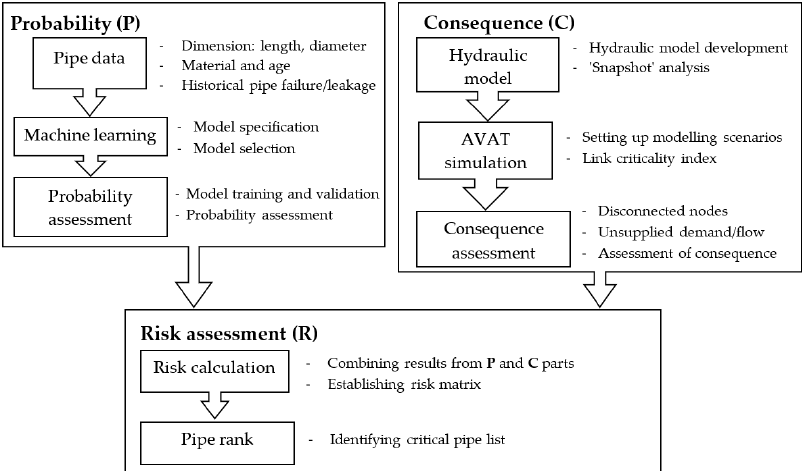
Figure 2. Workflow of Probability (P), Consequence (C), and Risk Assessment (R) applied in the study.